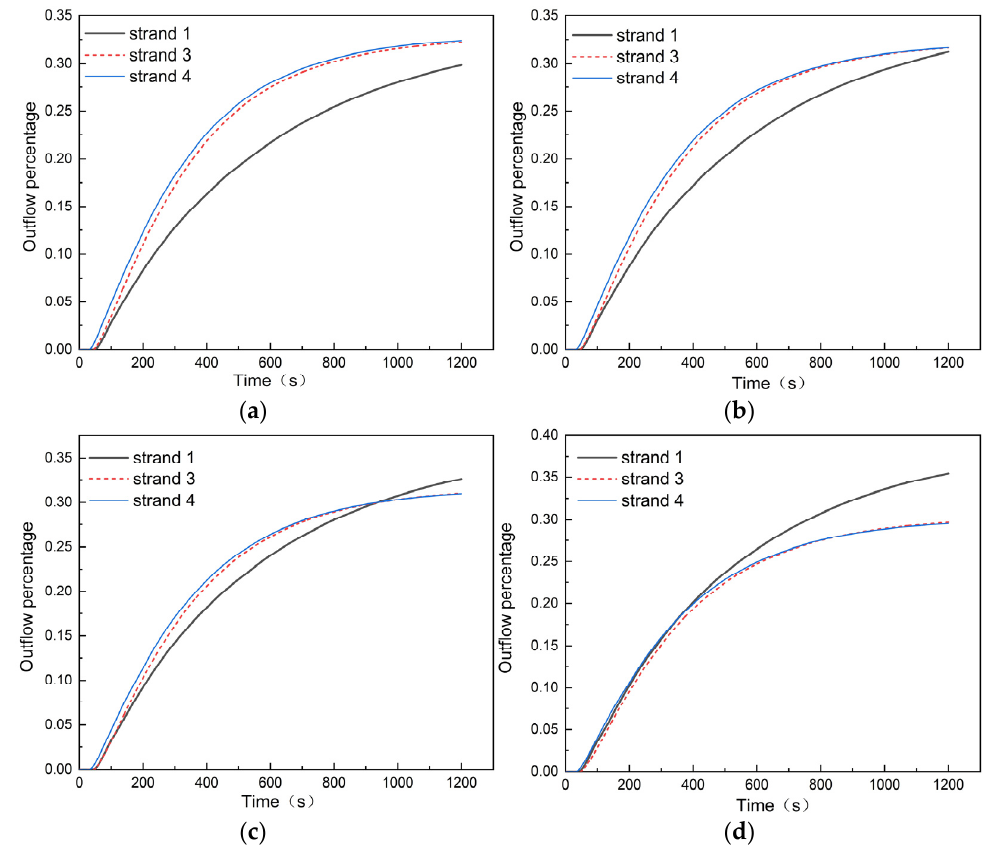
Figure 23. Outflow percentage curve of the double-weir tundish with non-uniform increasing casting flow rate under strand 2 blockage conditions: ( a ) 1.4 q, 1.3 q, 1.3 q, ( b ) 1.45 q, 1.275 q, 1.275 q, ( c ) 1.5 q,